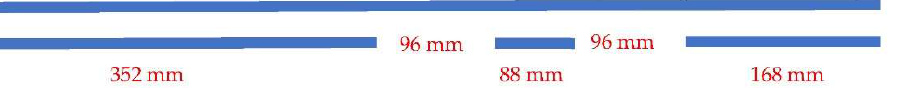
Figure 20. Schematic representation of the beam under investigation, half span. Visualization of the top caps of the longitudinal C-spar. Position of the flaws.